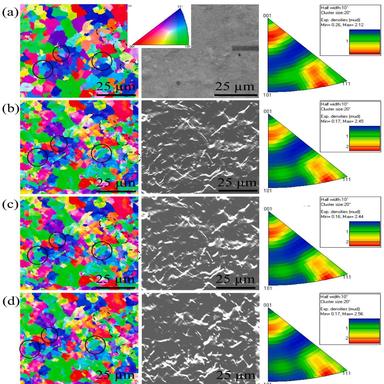
On the left: EBSD mappings, in the middle: SEM images and on the right: inverse pole figure (IPF) X mapping of the centre of the DP600 specimen at (a) uniaxial start, (b) uniaxial end, (c) biaxial start and (d) biaxial end during continuous strain path change.